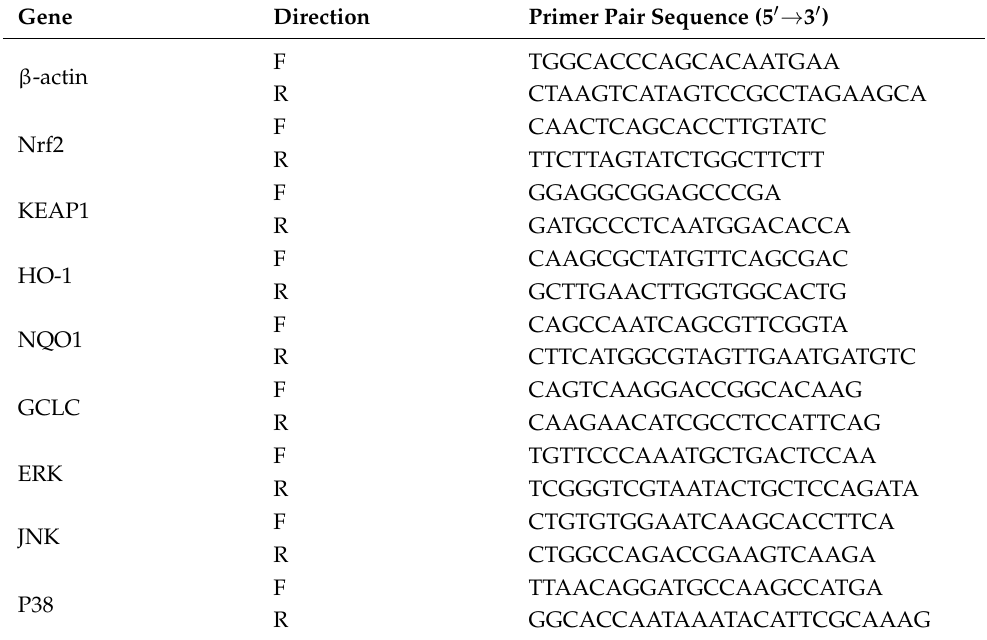
Table 1. RT-PCR Primer